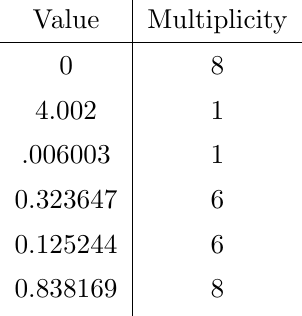
Table 12 . Numerical results where cubic terms are included for the scalar mass eigenstates of